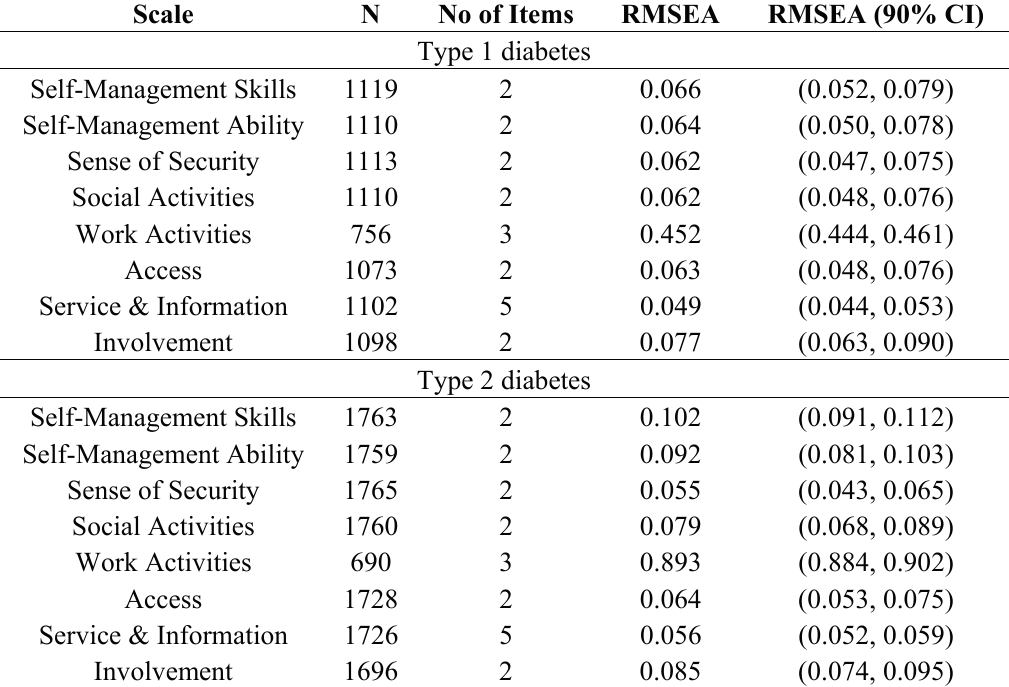
Table A1. Summary of scale properties for the final scales: number of complete cases (N) and root mean square error of approximation (RMSEA) with 90% confidence intervals (CI), based on M , by type of 2